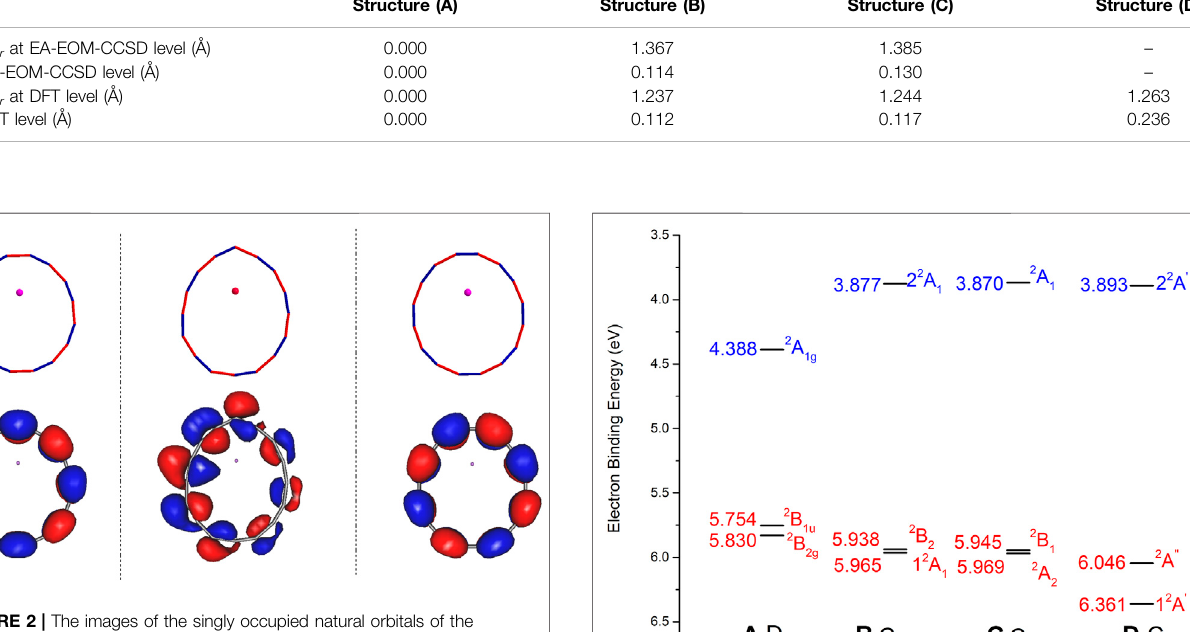
FIGURE 2 | The images of the singly occupied natural orbitals of the ground states of the off-center Li@C 16 structures. The left and right panels show the SONOs for the C 2 v structure (b) and (c) of Figure 1 where the Li + is closer to the single and the triple C-C bond, respectively. The middle panelrelatestotheC s structure(d)ofPanel1,wheretheLi + pointstothetopC atom. The surfaces shown enclose 80 % of the electron density.